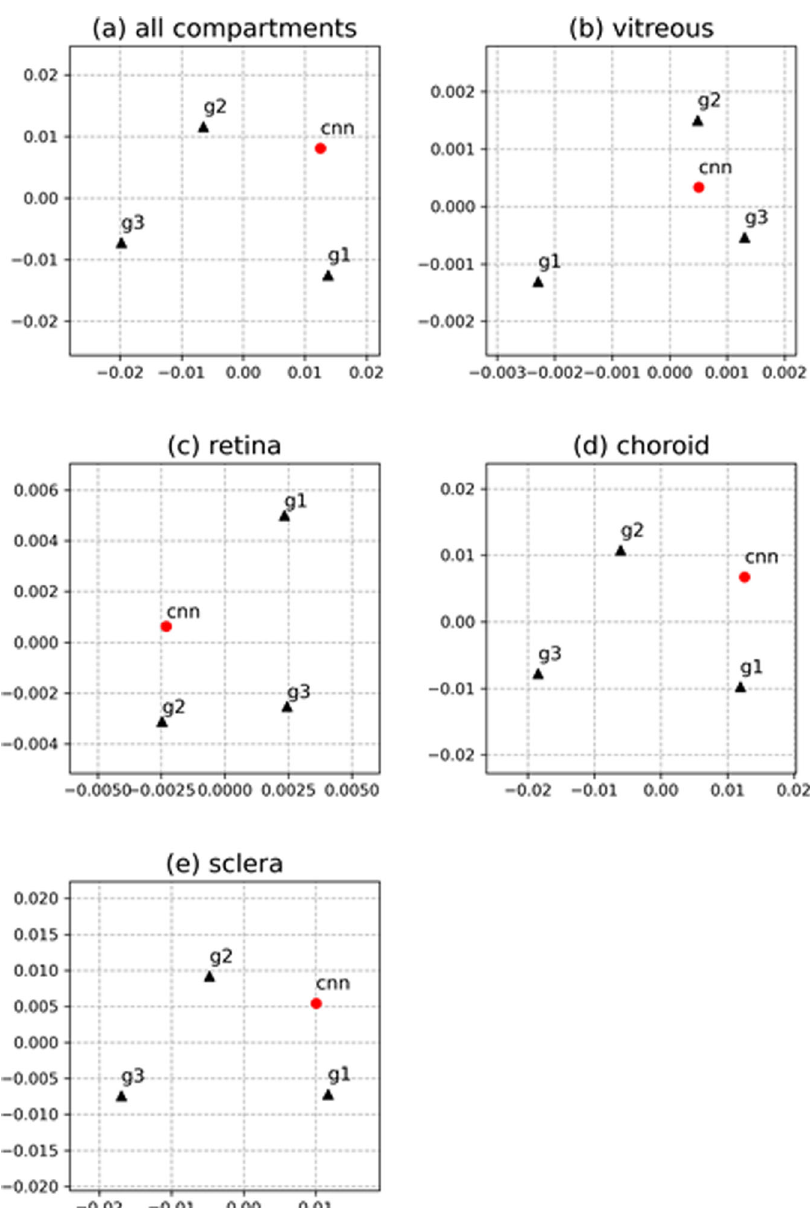
Fig. 4 Multidimensional scaling plots of mean Hamming distance. Results between labels of grader 1 (g1), grader 2 (g2), grader 3 (g3), and CNN predictions are depicted. The axes have no unit and represent Hamming distances. Multidimensional scaling places g1, g2, g3, and CNN in a two- dimensional coordinate system such that distances between g1, g2, g3, and CNN correspond to the mean Hamming distances as accurately as possible. Multidimensional scaling plots are shown for a all compartments, b vitreous compartment, c retina compartment, d choroid compartment, and e sclera compartment. g1, g2, and g3 are shown as black triangles. CNN is shown as a red circle. Depending on the compartment, the CNN showed a different averaging behavior with respect to the human